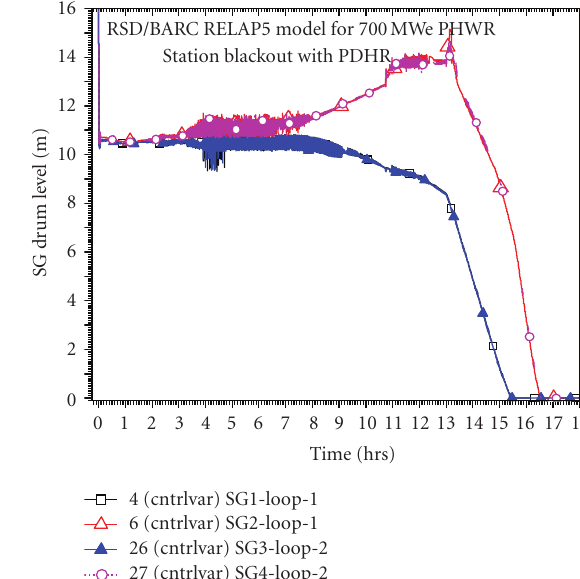
Figure 13: SG level variation case-no delay in valving in PDHRS.